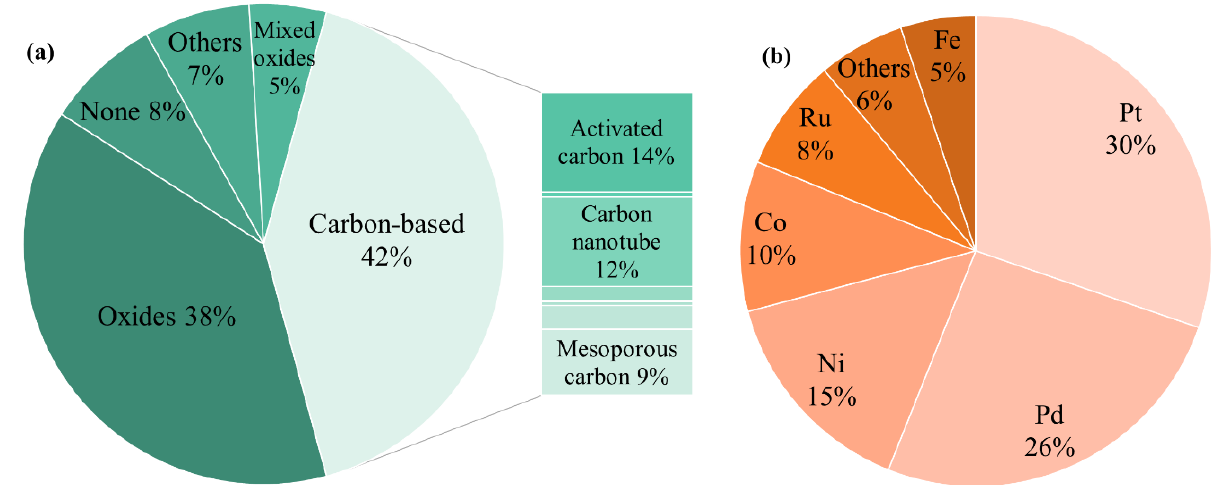
Figure 5. Distribution of catalyst carriers ( a ) and primary active metals in catalyst studies ( b ).